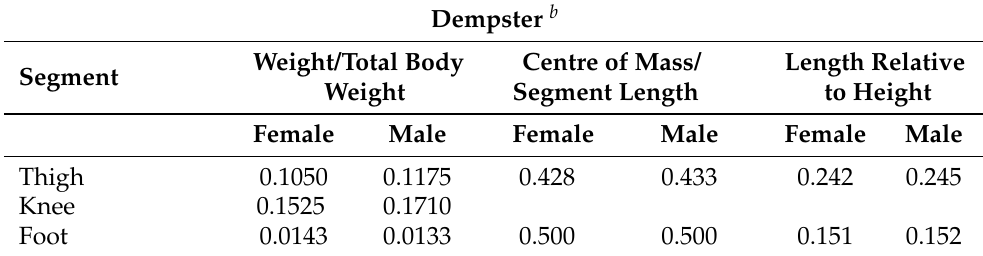
Figure 8. Calculation of Segment Masses, Centres of Mass and Length of Segment in LabView. Table 4. Body segment coefficients as calculated for Dempster model.